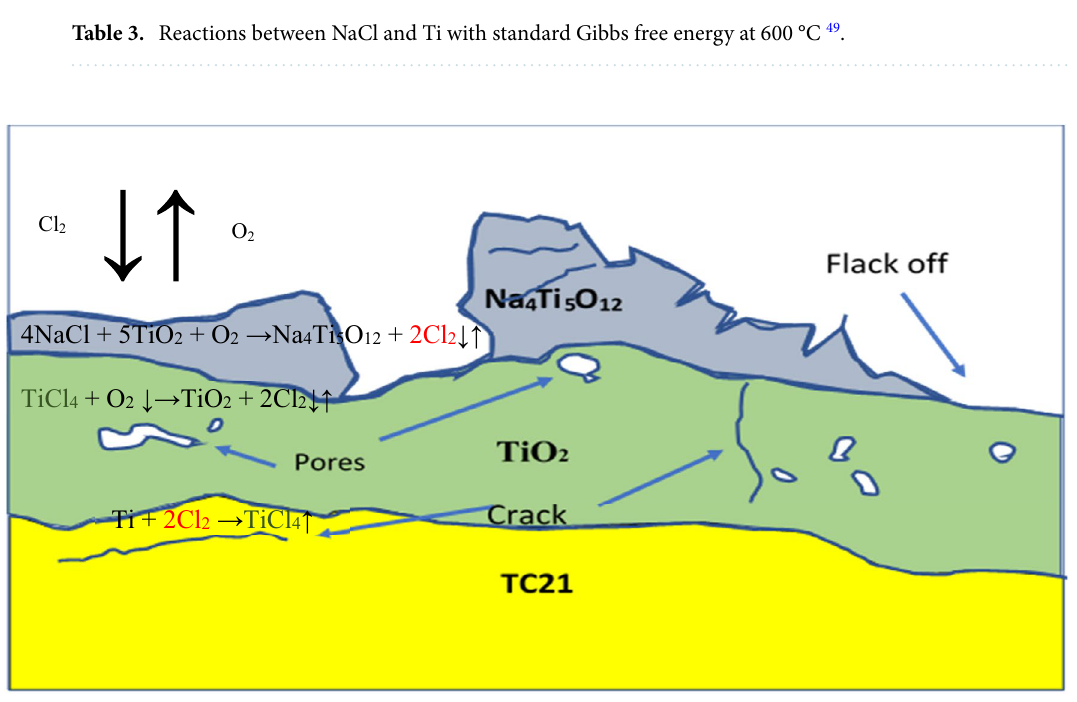
Figure 18. Schematic diagram was the corrosive layer formation under the raw material’s hot corrosion